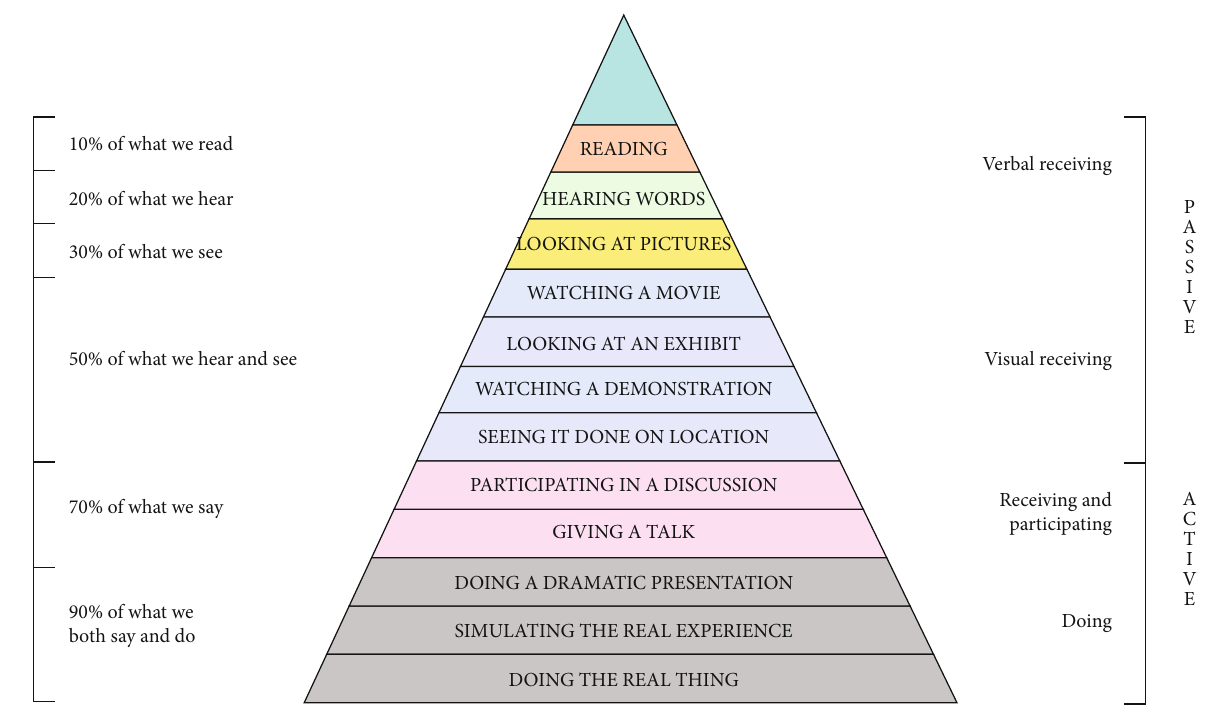
Figure 1: Dale ’ s Cone of Learning